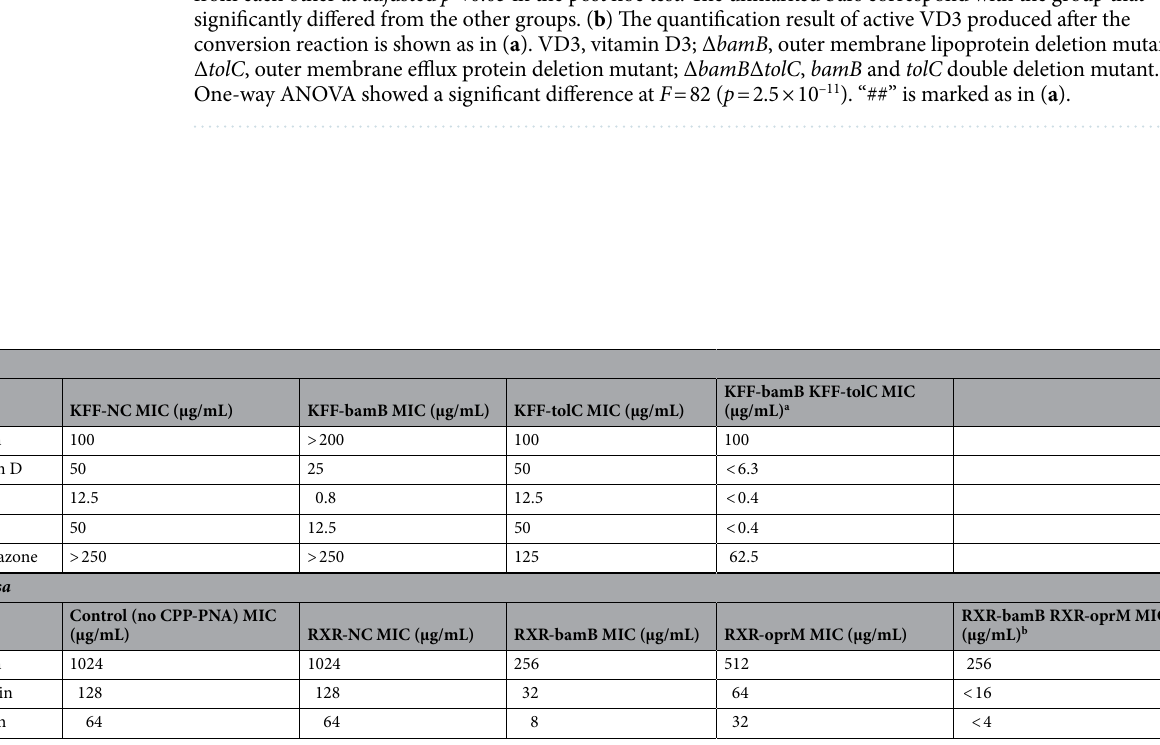
Table 2. MIC of antibiotics for E. coli and P. aeruginosa in the presence of CPP-PNAs. CPP-PNAs were added at the concentration of 5 and 3 μM for E. coli and P. aeruginosa , respectively. a In the presence of both CPP- PNAs, equimolar KFF-bamB and KFF-tolC were mixed. b In the presence of both CPP-PNAs, equimolar RXR- bamB and RXR-oprM were